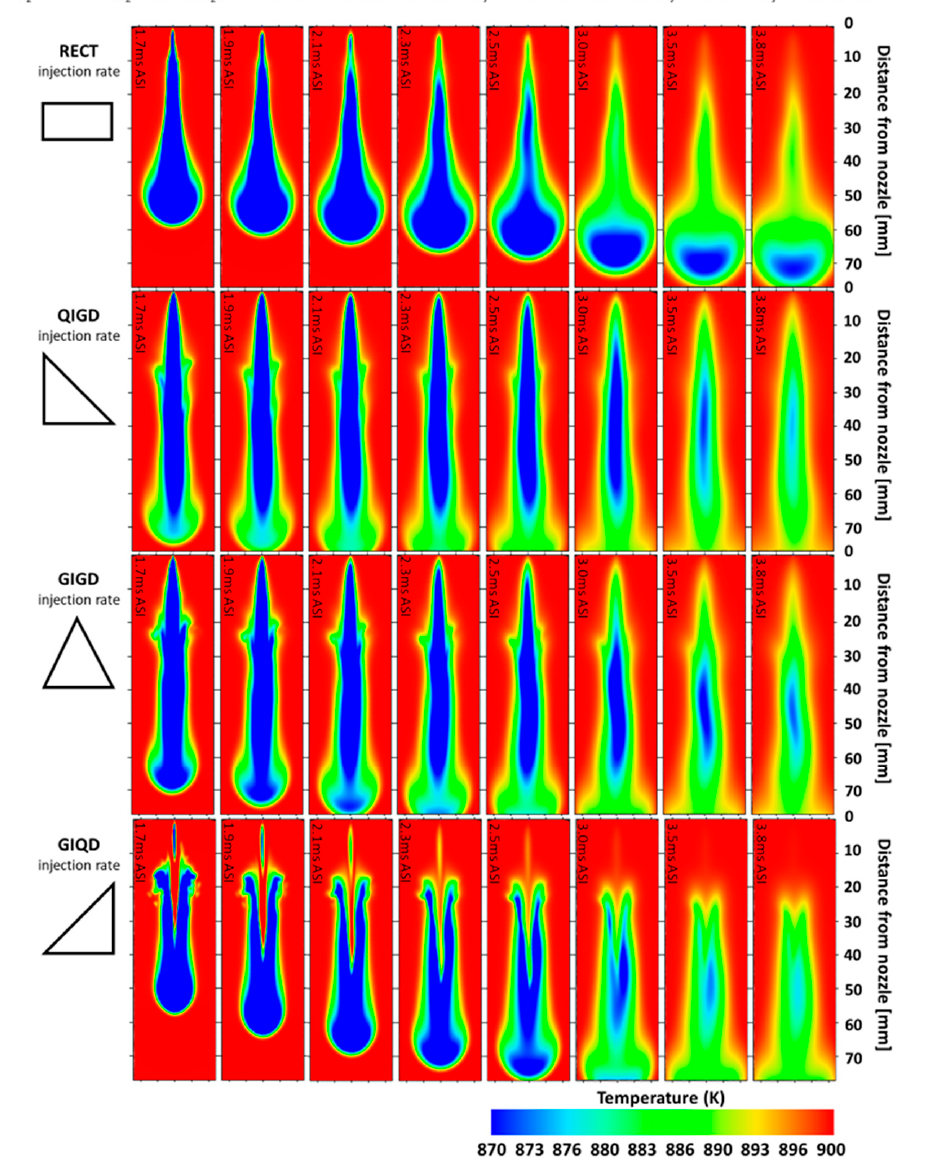
Figure 19. Comparison of temperature distribution after the EOI for different injection rate shapes.